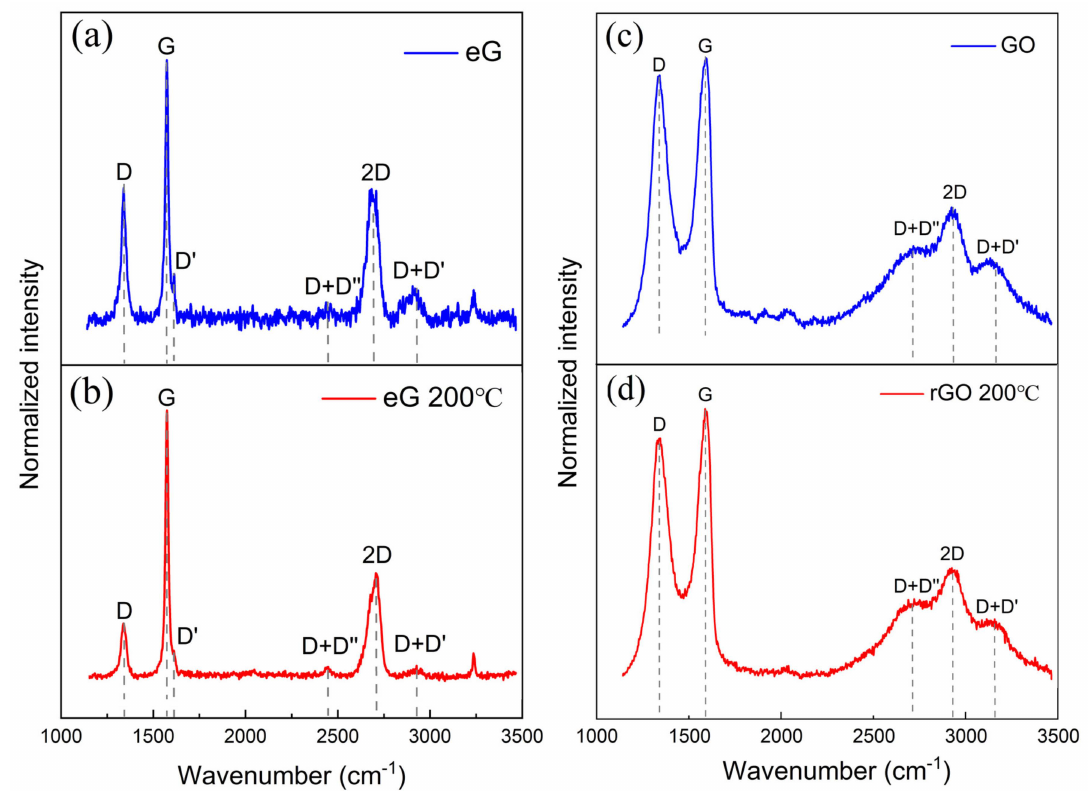
Figure 4. Raman spectra of eG ( a ) before and ( b ) after thermal annealing at 200 ◦ C and of GO ( c ) before and ( d ) after thermal annealing at 200 ◦